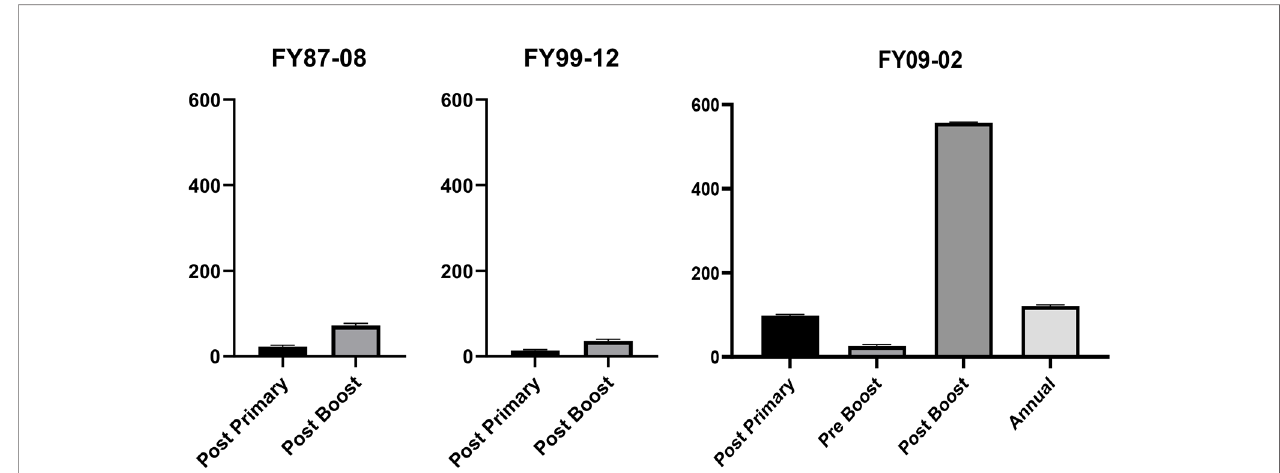
FIGURE 2 | In FY87-08 protocol, post primary* GMT (Geometric Mean Titers) was 23.3 [21.5, 25.2], and post booster* GMT was 72.2 [63.3, 82.4]. In FY99-12, post primary † GMT (Geometric Mean Titers) was 14.1 [12.1, 16.5], and post booster † GMT was 36.9 [30.1, 45.3]. In the FY09-02 protocol, GMT day 56 ‡ was